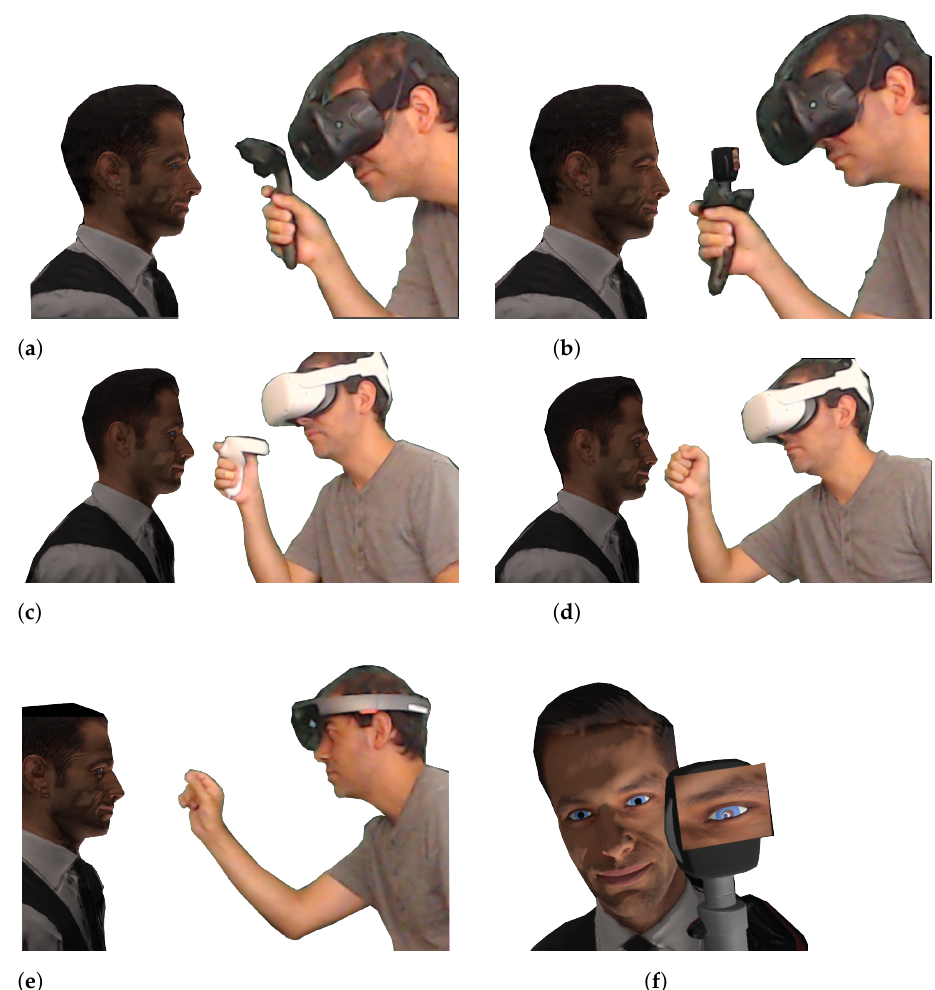
Figure 3. Virtual patient examination with five different 3D user interface devices. ( a ) HTC Vive controller. ( b ) Valve Index controller. ( c ) Oculus Quest 2 controller. ( d ) Oculus Quest 2 hand tracking. ( e ) Microsoft HoloLens 1 Pinching gesture. ( f ) Ophthalmoscope view with